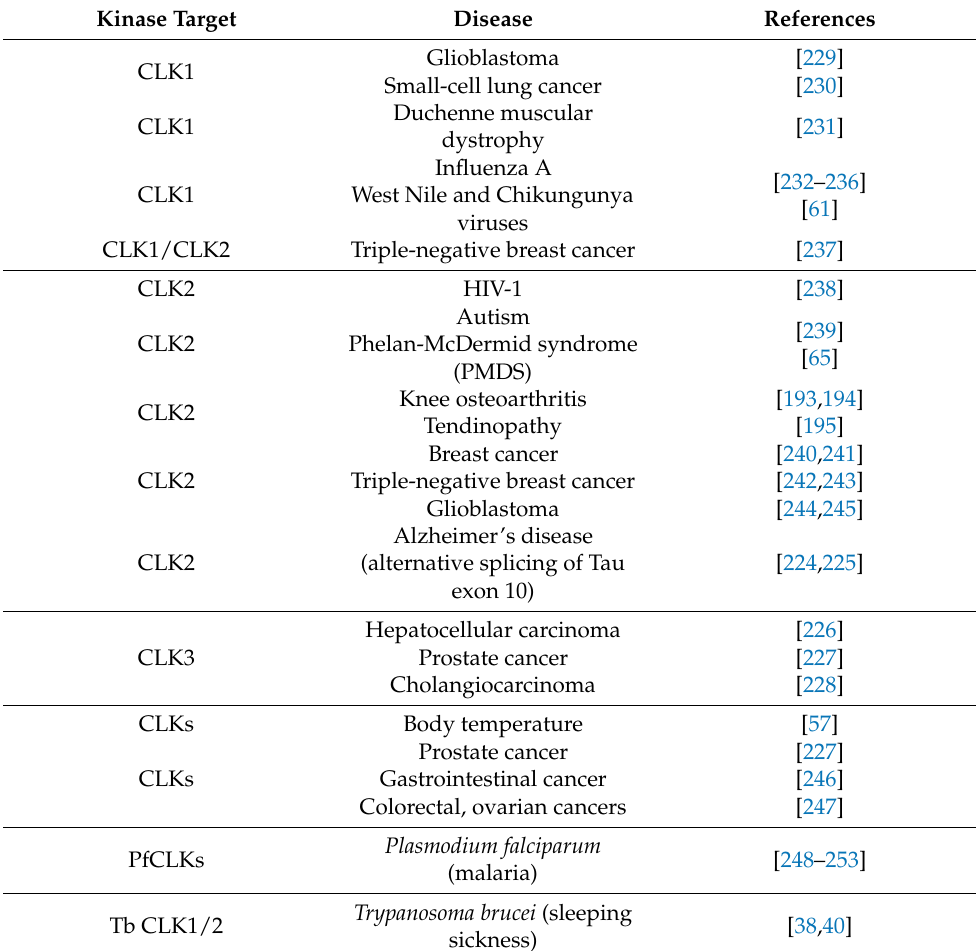
Table 4. CLKs and human disease. Evidence for causality and beneficial effects of pharmacological treatment by CLK